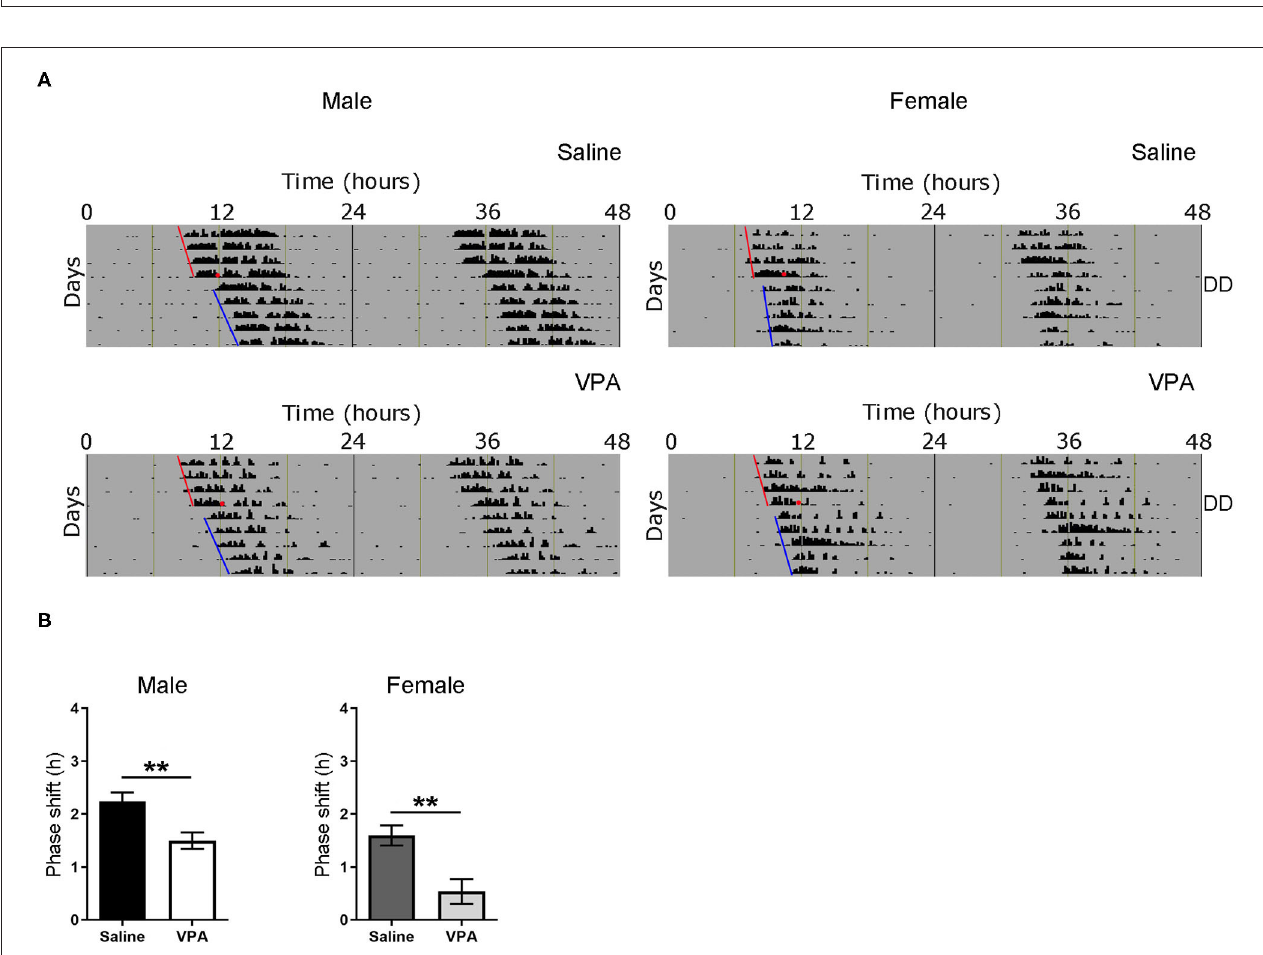
FIGURE 3 | maintained under constant light conditions. (B) Both VPA-exposed males and females demonstrate an increase in the number of days needed to reach arrhythmic behaviour, in comparison to their respective control counter parts (males; saline: M = 12.89 ± 0.5638, VPA: M = 23.93 ± 2.069, p < 0.0001. Females: saline: M = 18.75 ± 2.171, VPA: M = 38.75 ± 2.926, p < 0.0001). (C) Both VPA-exposed males and females show an attenuated negative masking response under LL conditions, represented by a ratio of (10 d average of total activity in LL)/(10 d total activity in LD) (Males; saline: M = 0.1895 ± 0.03219, VPA: M = 1.100 ±